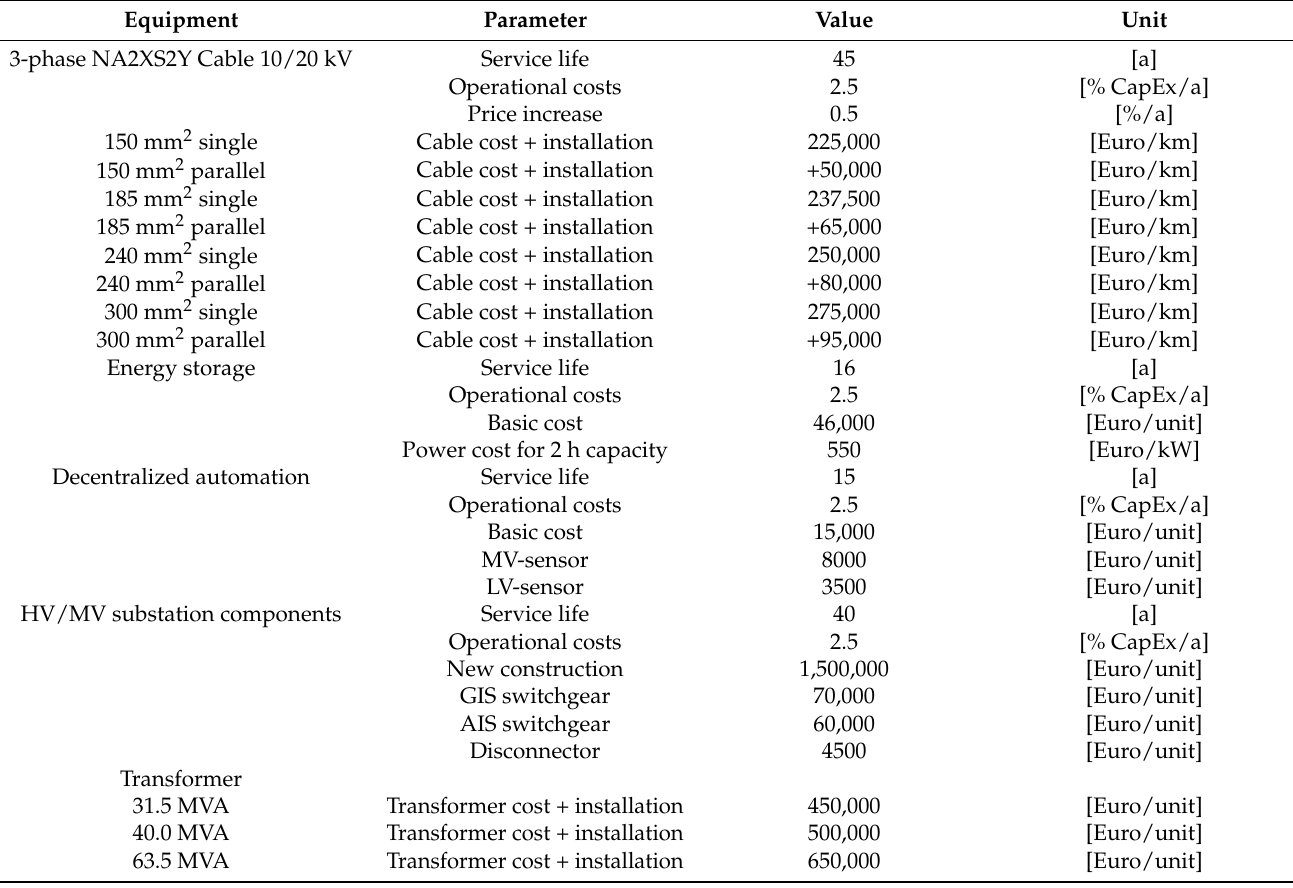
Table A3. Assumed costs for the applied medium voltage